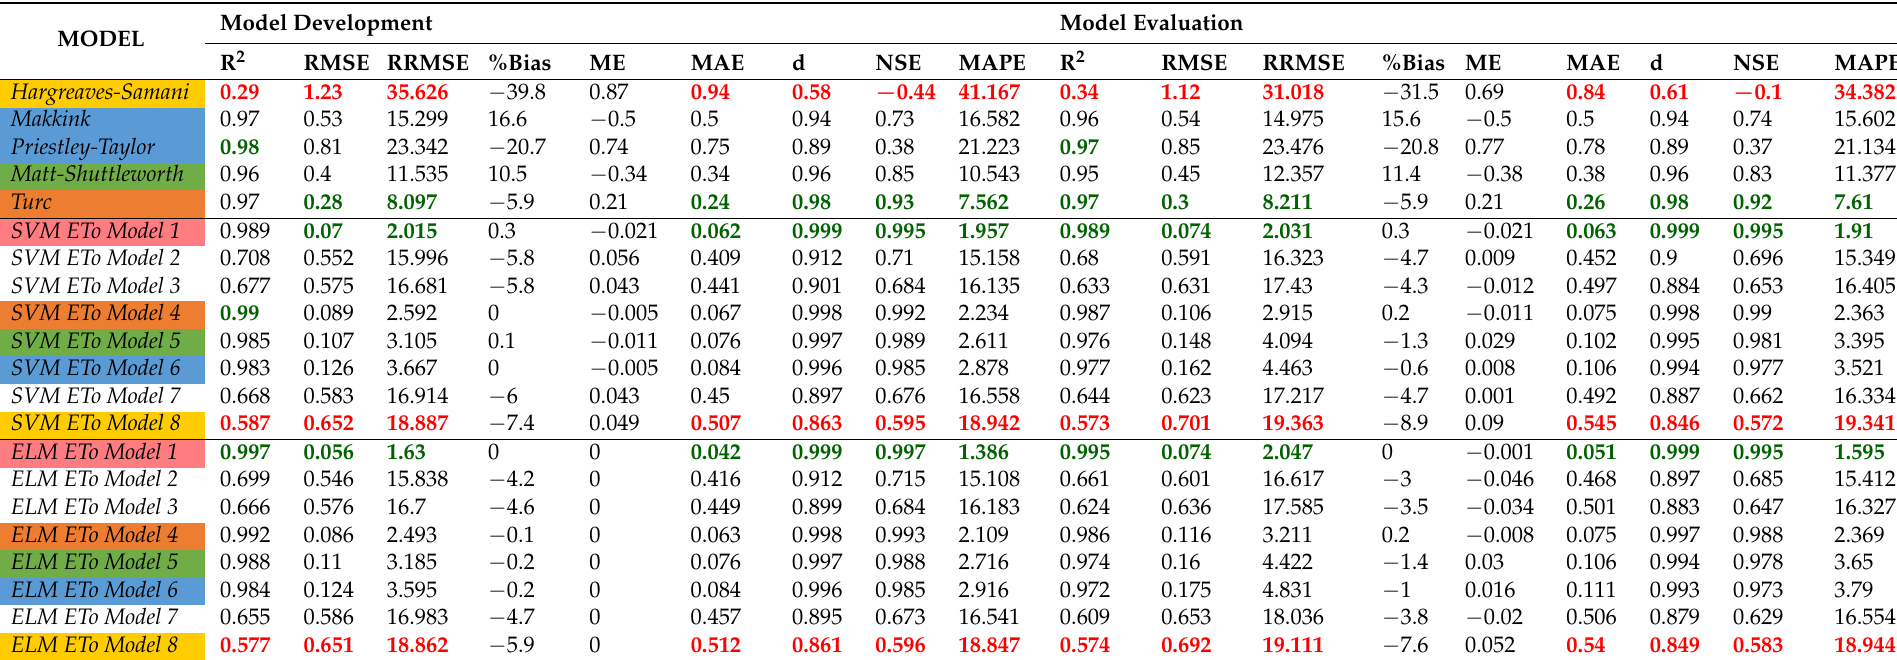
Table 9. Statistical values of empirical and machine learning models used for estimating daily ETo at Tayabas Station